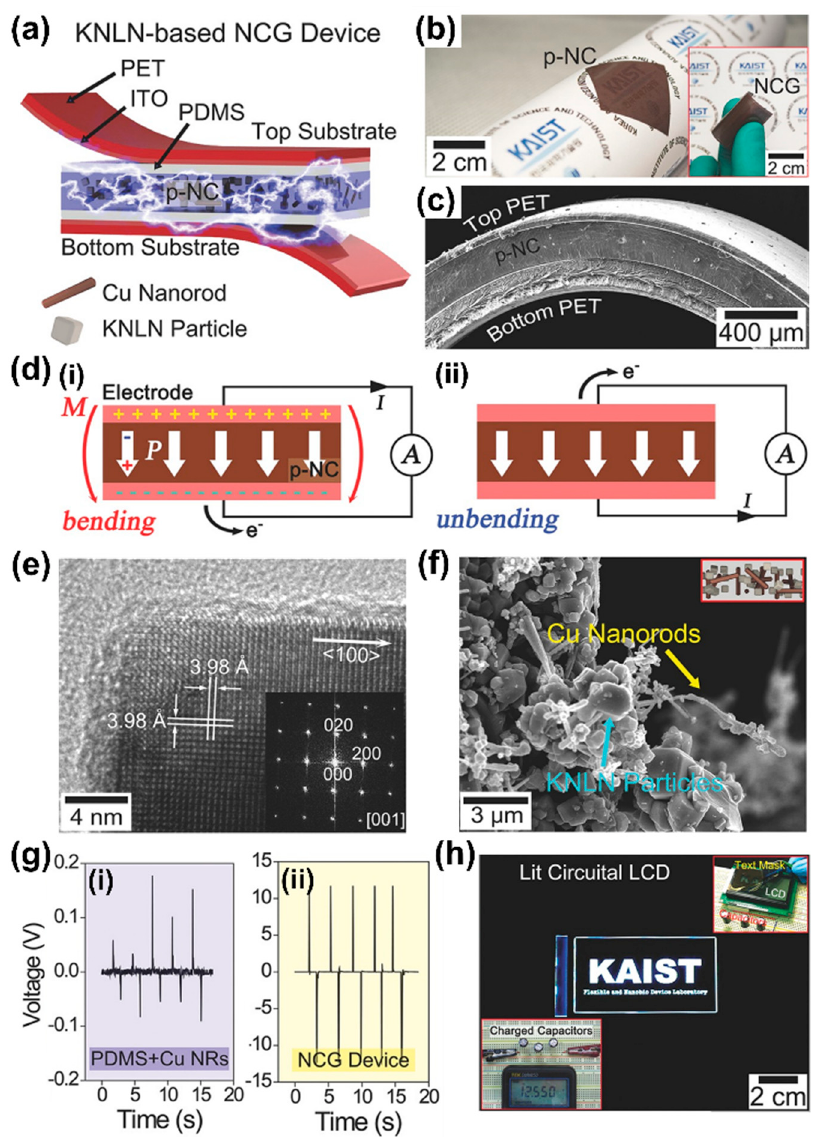
Figure 3. ( a ) Schematic diagram of NCG device containing KNLN particles and Cu NRs. ( b ) Photo- graph of flexible p − NC layer attached to the curved surface of the paper. ( c ) Cross − sectional SEM image of bent NCG device embedded with KNLN particles. ( d ) Schematic diagram of the power generation mechanism of NCG during ( i ) bending and ( ii ) unbending state. ( e ) HRTEM image of FFT analysis (inset Figure) of KNLN particles. ( f ) SEM image of mixed nanomaterials made by KNLN particles and Cu NRs. ( g ) Generated voltage from devices made of ( i ) PDMS and Cu NRs and ( ii ) NCG devices composed of Cu NRs and KNLN particles. ( h ) Photograph of commercial LCD device operated by charged capacitors by NCG (bottom inset) and LCD device circuit with a text mask (top inset). Reproduced with permission [59].